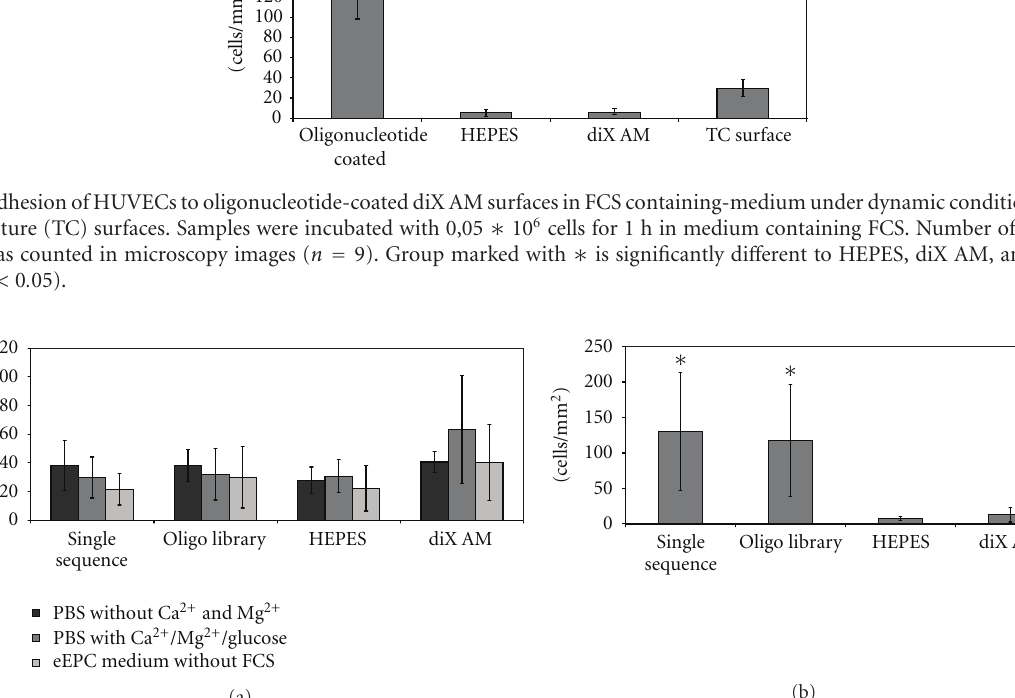
5% · CO 2 . After 1 h, all the nonadherent cells were washed o ff and the adherent cells incubated for a further 22